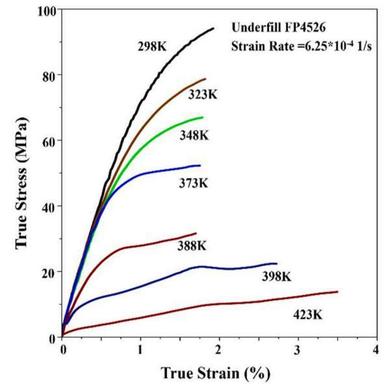
Tensile Test Results of FP4526 Underfill at Different Temperatures under Strain Rate 6.25\10− 4 s − 1 ..